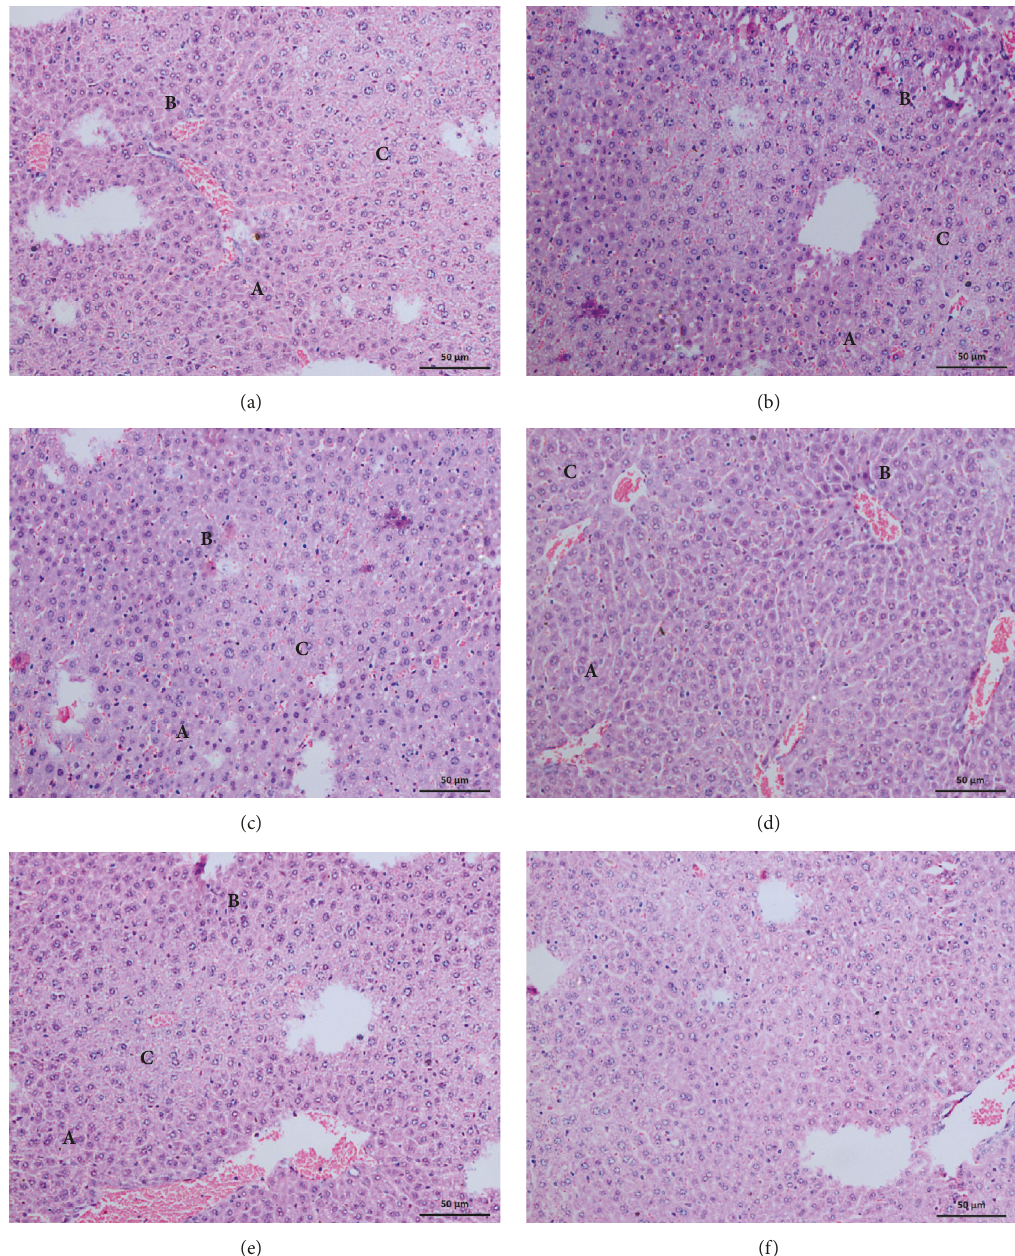
Figure 6: Histopathological changes in liver, after 3hr from injection of N. naja venom from (a) Western Region Population, (b) Central Region Population, (c) North Region Population, (d) Sabaragamuwa Region Population, (e) Southern Region Population, and (f) Control. (A) Lytic necrosis. (B) Hepatocyte degeneration. (C) Zonal hepatocellular